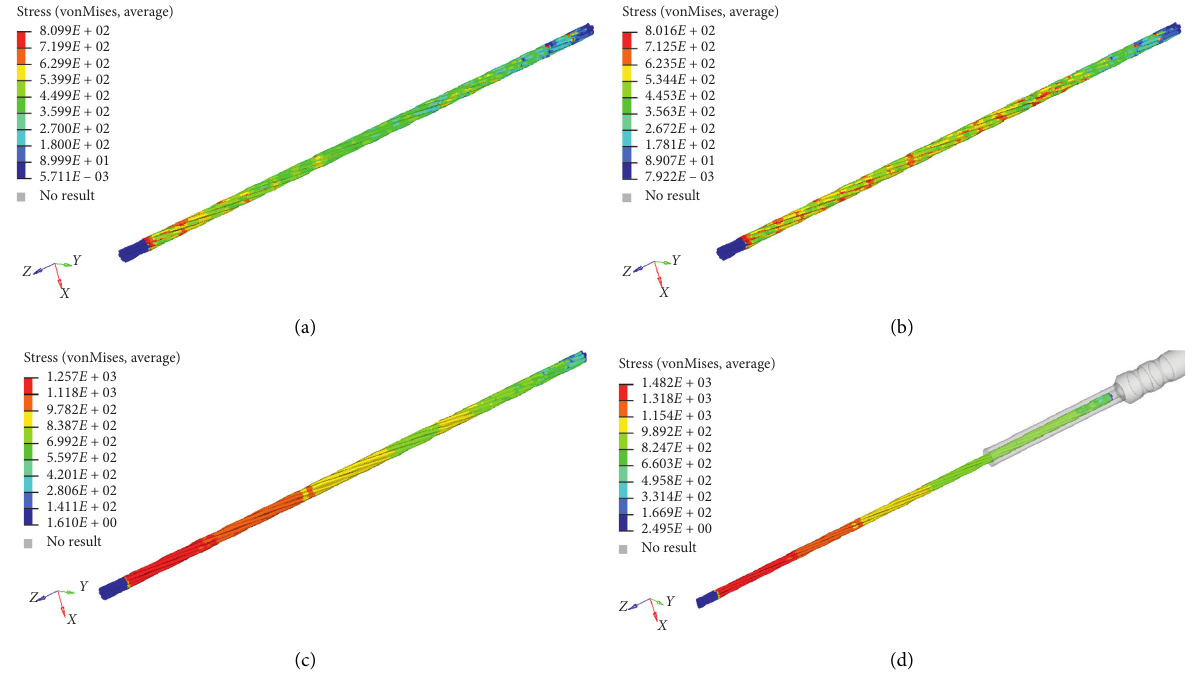
Figure 17: Stress nephograms of the steel core under different tensile loadings: (a) 25% RTS; (b) 50% RTS; (c) 95% RTS; (d) ultimate